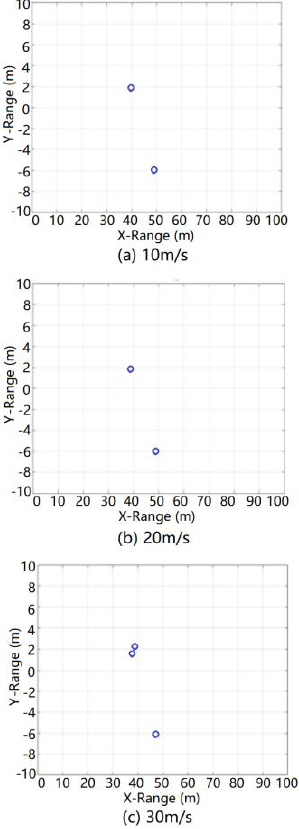
Figure 20. Results of ground clutter after digital beam forming (DBF) processing during simulation.